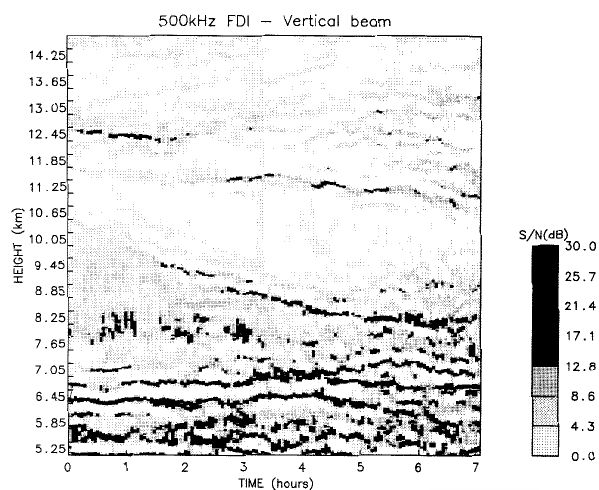
Fig. 6. Time-height cross sections of vertical signal-to-noise ratio after dual FDI processing with 1f = 0 . 5 MHz and an initial 300-m range resolution with the MU radar. Thinner echoing layers than 300m can be detected and more details on their vertical displace- ments seem to appear (after Kilburn et al.,